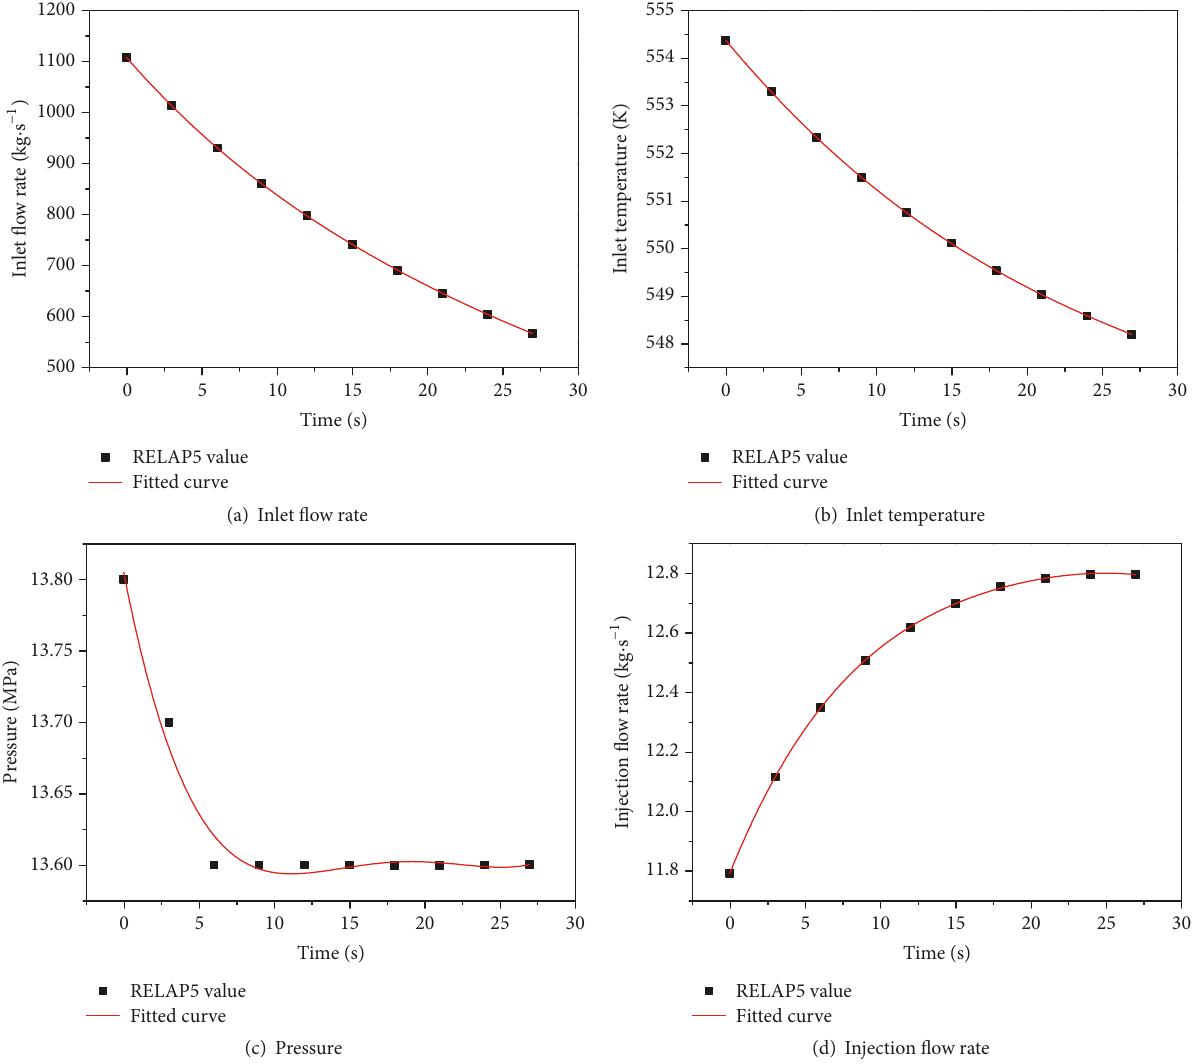
Figure 11: Fitted boundary conditions from 123 s to